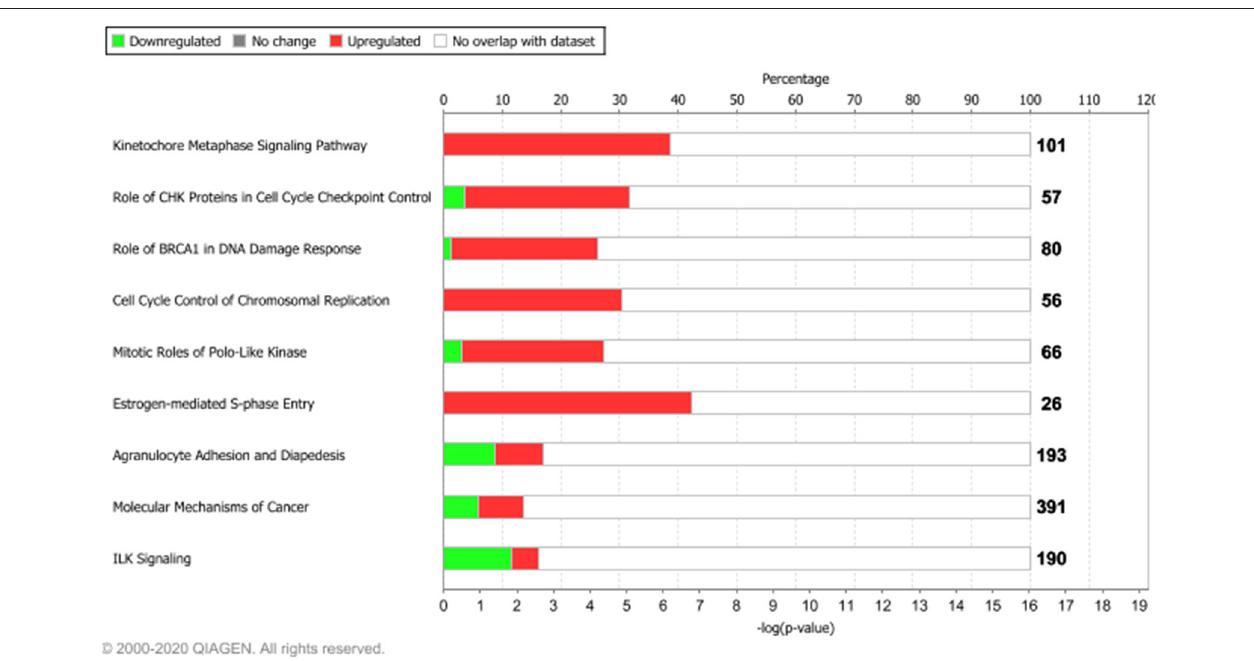
FIGURE 3 | Functional enrichment analysis of the 1,642 tumor-associated genes. The top 10 enriched pathways, ranked for enrichment score with threshold ≥ 5 [–log( p -value), based on Fisher’s exact test]. Bolded numbers on the right represent the total amount of genes within each IPA canonical pathway. Dataset analyzed by the Ingenuity Pathway Analysis, QIAGEN software,